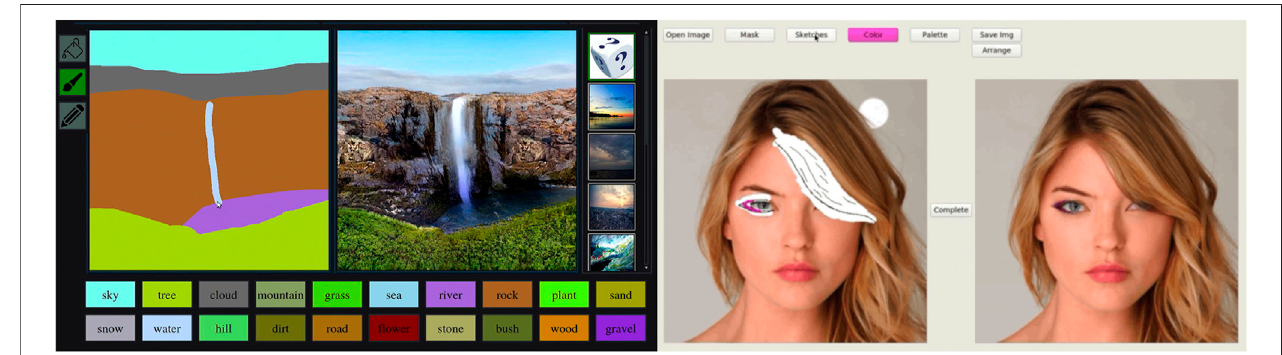
FIGURE10|Left: Theinterface fortheGauGANsystem(Park et al.,2019).Theusercancreaterealistic landscapeswithjustafew simpleinputstrokes. Right: Jo and Park (2019) developed a very familiar painting-based interface that allows users to alter photographs via